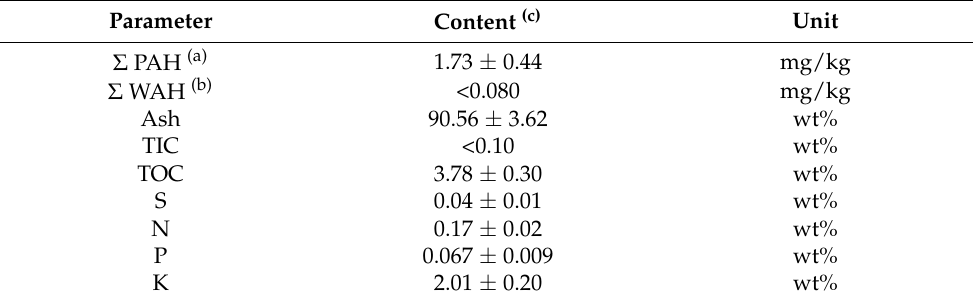
Table 6. Physicochemical characteristics of anthropogenic land soil (sample SW).